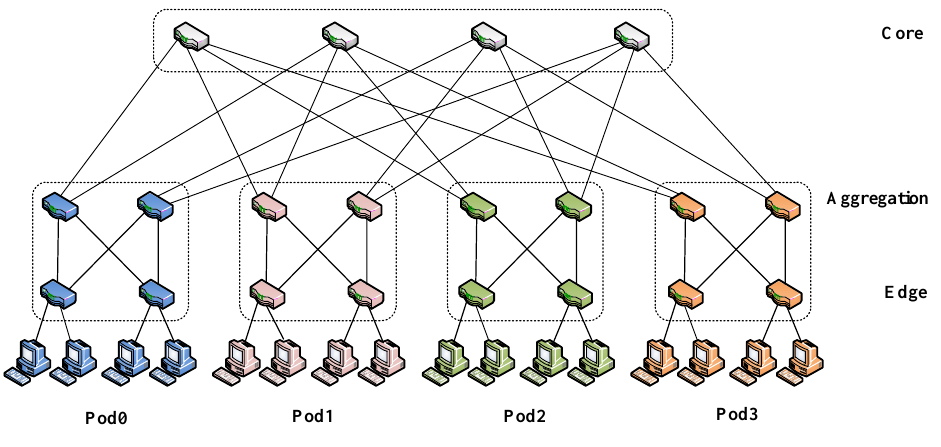
Figure 1. An example of Fat-Tree DCN topology with